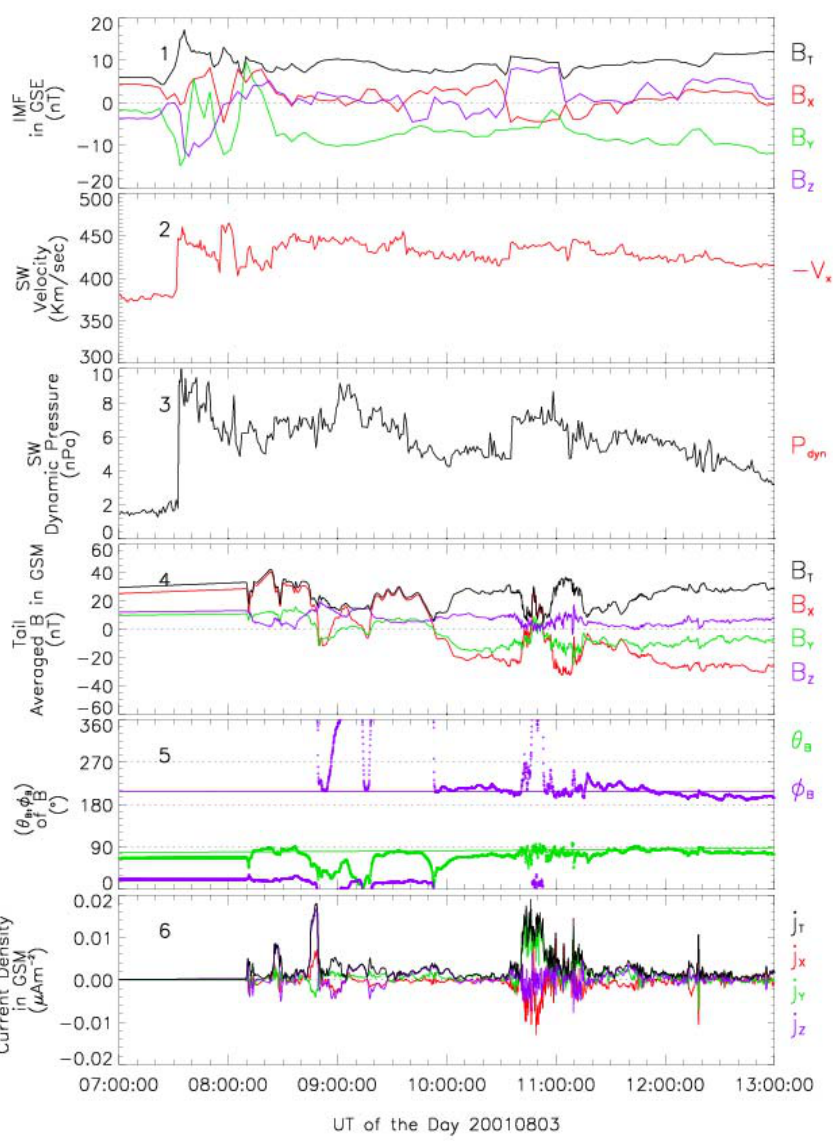
Fig. 9 The solar wind conditions as observed by the ACE spacecraft and the physical quantities of the tail current sheet measured by Cluster during the tail flapping event on 3 Aug 2001. Cluster is at 19Re geocentric distance, at the nightside equatorial plane, and its polar angle θ and azimuthal angle ϕ in GSM are about 81 ◦ and 207 ◦ , respectively. Panel 1: the interplanetary magnetic field (IMF) in GSE; panel 2: The velocity of the solar wind; panel 3: the dynamic pressure of the solar wind; panel 4: the magnetic field at the center of Cluster tetrahedron as are the average of those at the four S/C in GSM; panel 5: the directional angle ( θ B , ϕ B ) of the magnetic field at the center of Cluster tetrahedron in GSM; panel 6: The three components ( j x , j y , j z ) of the current density at the center of Cluster tetrahedron at GSM coordinates. In panels 4–6, the data before 08:10UT are pseudo due to the unavailability of actual observation data.